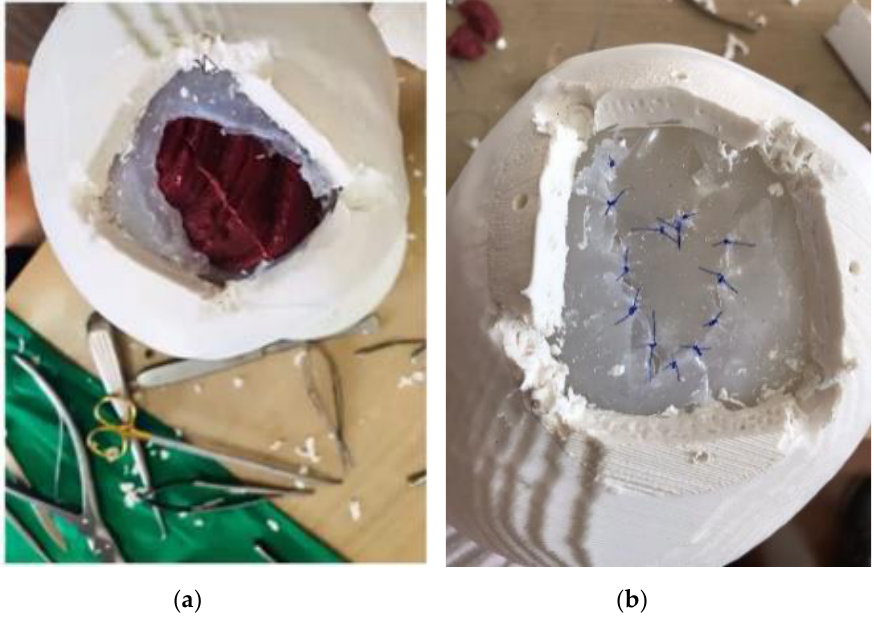
Figure 10. Tumor inside the brain ( a ) and suturing the dura mater once the tumor was removed ( b ).